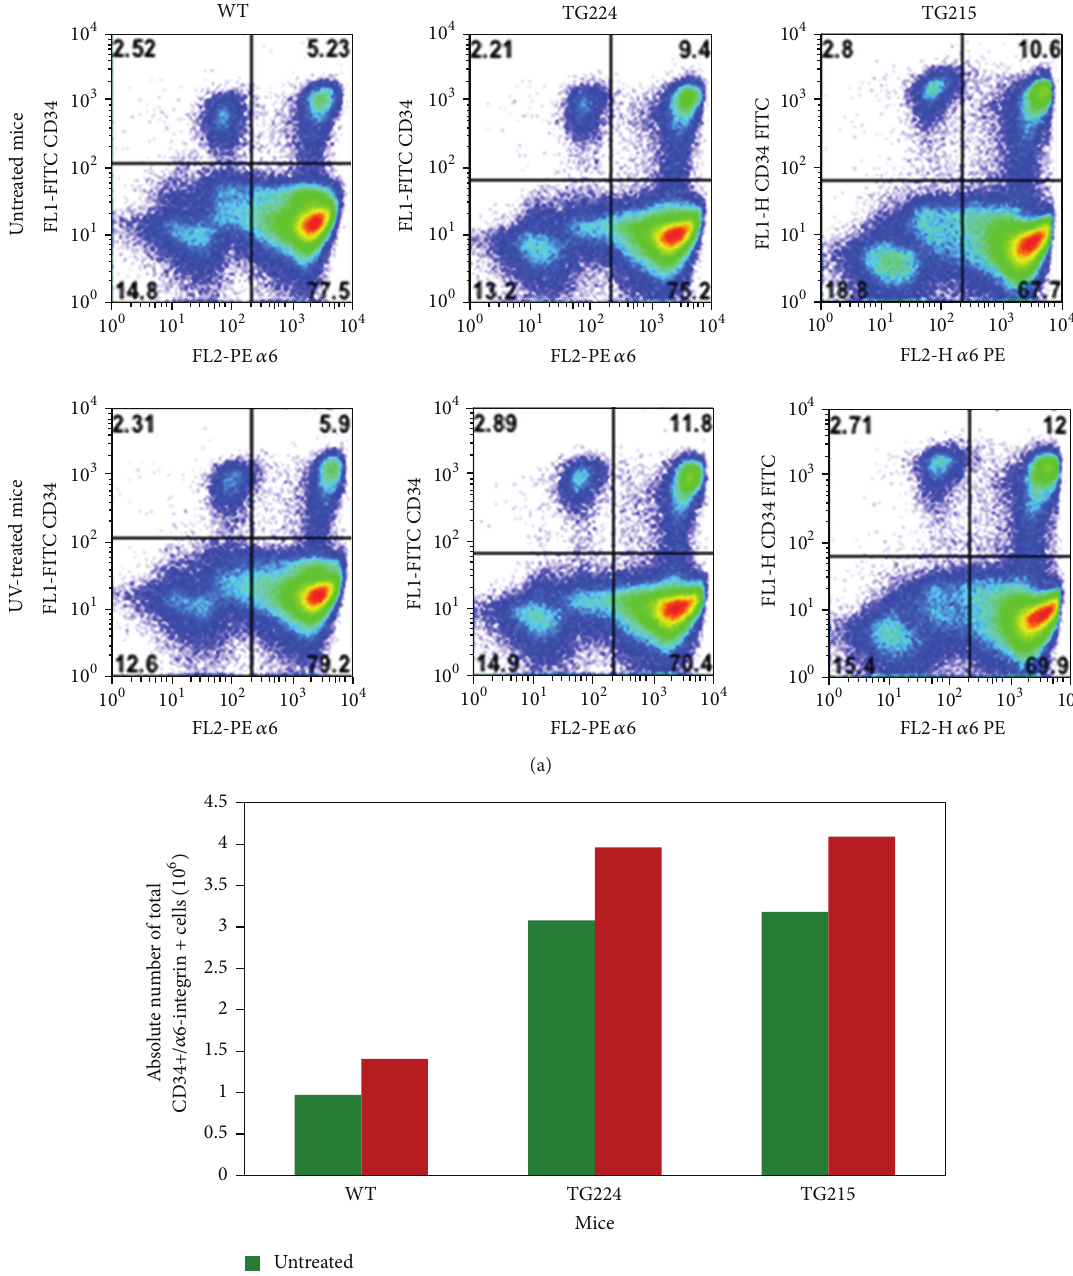
Figure 3: Effects of chronic UV exposures on live epidermal stem cell population determined by flow cytometric analysis. PKC 𝜀 overexpressing TG and their WT littermates were given total eight UV exposures (1.8kJ/m 2 , Monday, Wednesday, and Friday). At 24hr after the last UV exposure, mice were sacrificed and the dorsal skin removed for keratinocyte isolation. (a) Percent distribution of FACS- sorted keratinocytes following UV exposures of the indicated mice. (b) Frequency of total double positive HSCs (CD34+/ 𝛼 6-integrin+) keratinocytes in UV-treated